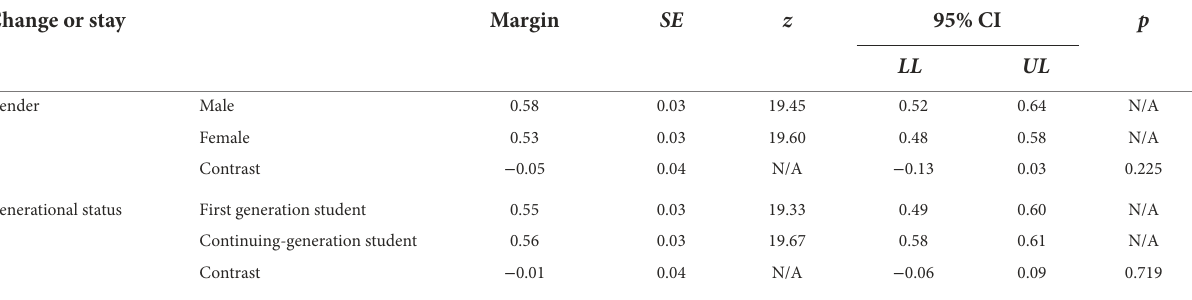
TABLE 6 Marginal means for subject change predicted by gender and generational